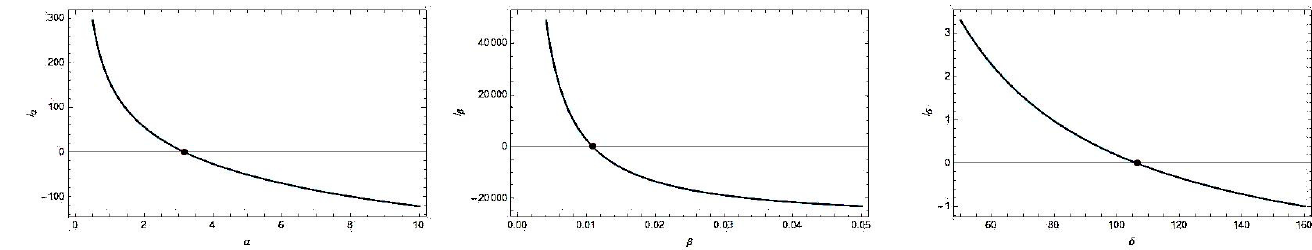
Figure 9. Existence and uniqueness plots for 3PB model parameters for stress ‐ rupture data set.